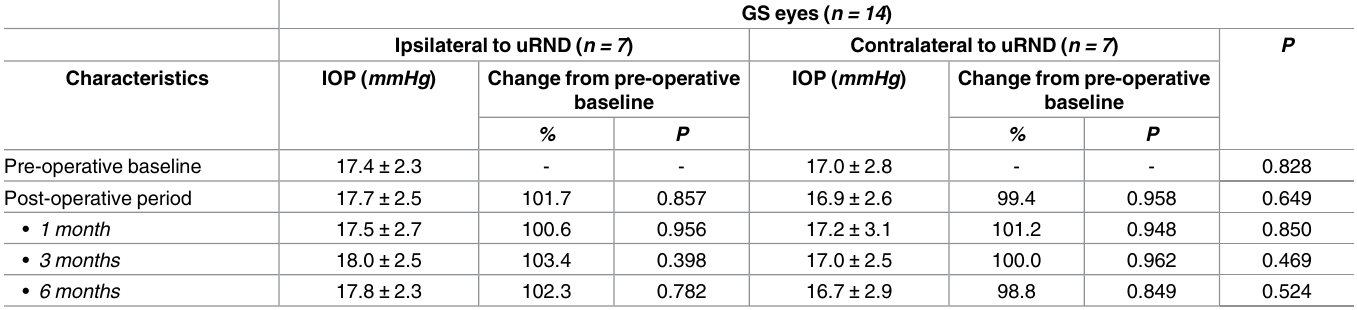
Table 5. IOP changes in non-treated-GS eyes after